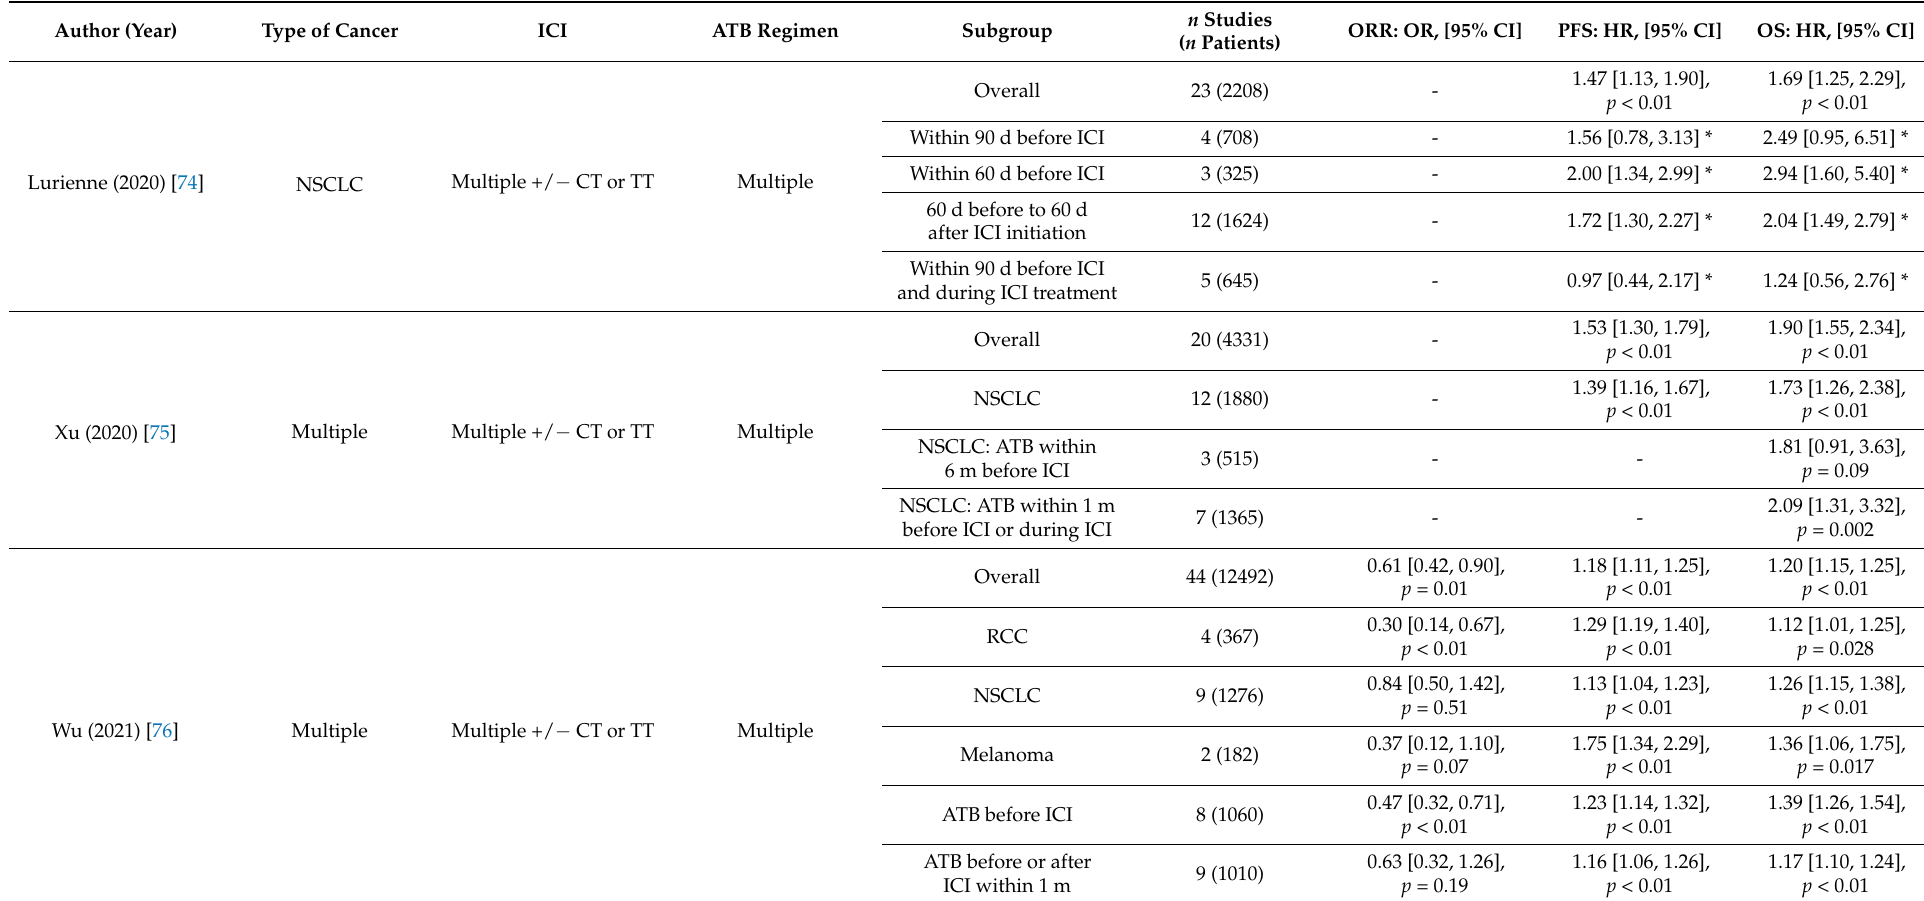
Table 4. Systematic reviews and meta-analyses on the impact of antibiotics with ICI treatment on response rate and survival